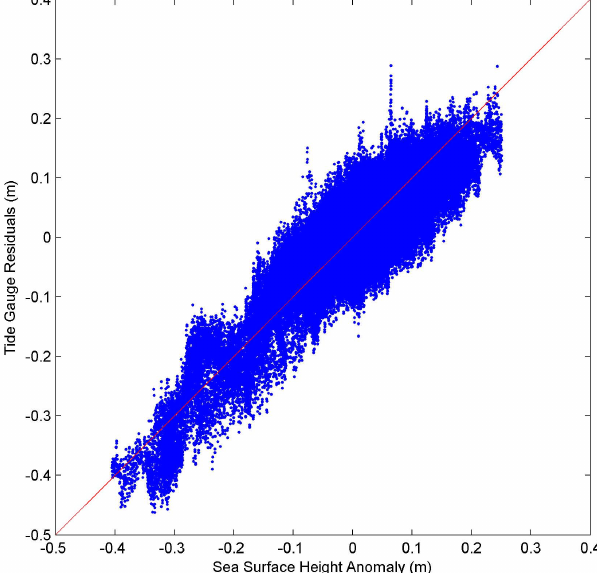
Fig. 2. Sampling points of satellite altimeter along-track Pass 173: data points are marked with purple dots, and the location of tide gauge is shown by the red triangle.